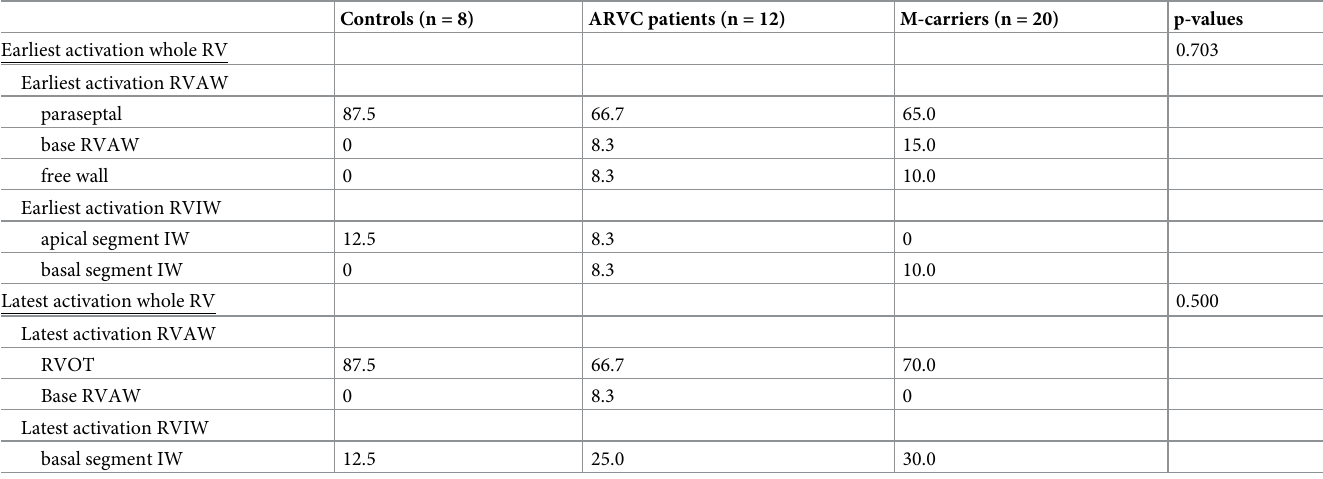
Table 3. Location of the earliest and latest activation of the